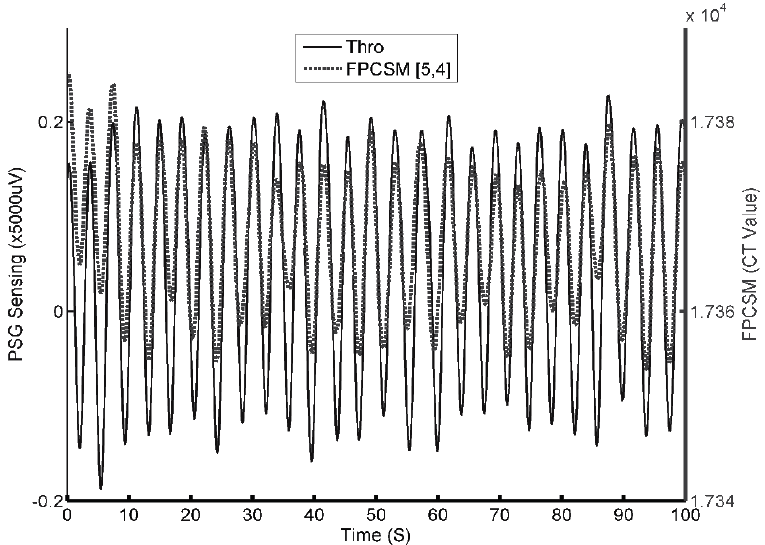
Figure 10. Respiration waves detected by the PSG and FPCSM